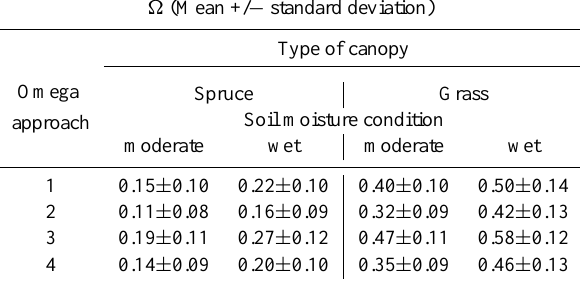
Table 2. Mean values and standard deviation of the omega ap- proaches according to Eqs. (1) to (4) and derived from measure- ments (half hour means) at the Anchor Station Grillenburg (grass) and Tharandt (spruce) during the summer season 2007. The data was filtered for solar radiation > 400Wm − 2 , high wind speed (fric- tion velocity u ∗ > 0.4ms − 1 for grass and u ∗ > 0.8ms − 1 for spruce) as well as for moderate (soil water content SWC < 30% for grass and SWC < 10% for spruce) and wet soil conditions (SWC > 40% for grass and SWC > 20% for spruce).